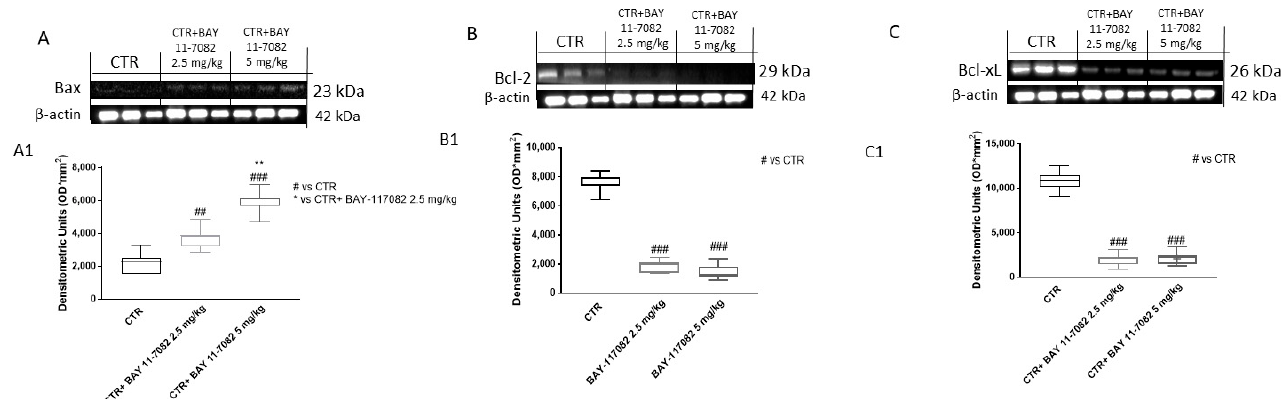
Figure 12. Effect of BAY-117082 on apoptosis pathway in CAL27 xenograft model. Blots reveal that ( A ) BAY-117082 treatment at doses of 2.5 and 5 mg/kg was able to increase Bax expression, and ( B , C ) Bcl2 and Bcl-xL expression was significantly reduced compared to control group. Data are representative of at least three independent experiments. ( A ) ## p < 0.01 vs. CTR; ### p < 0.001 vs. CTR; ** p < 0.01 vs. CTR + BAY-117082 2.5 mg/kg. ( B ) ### p < 0.001 vs. CTR; ( C ) ### p < 0.001 vs. CTR.